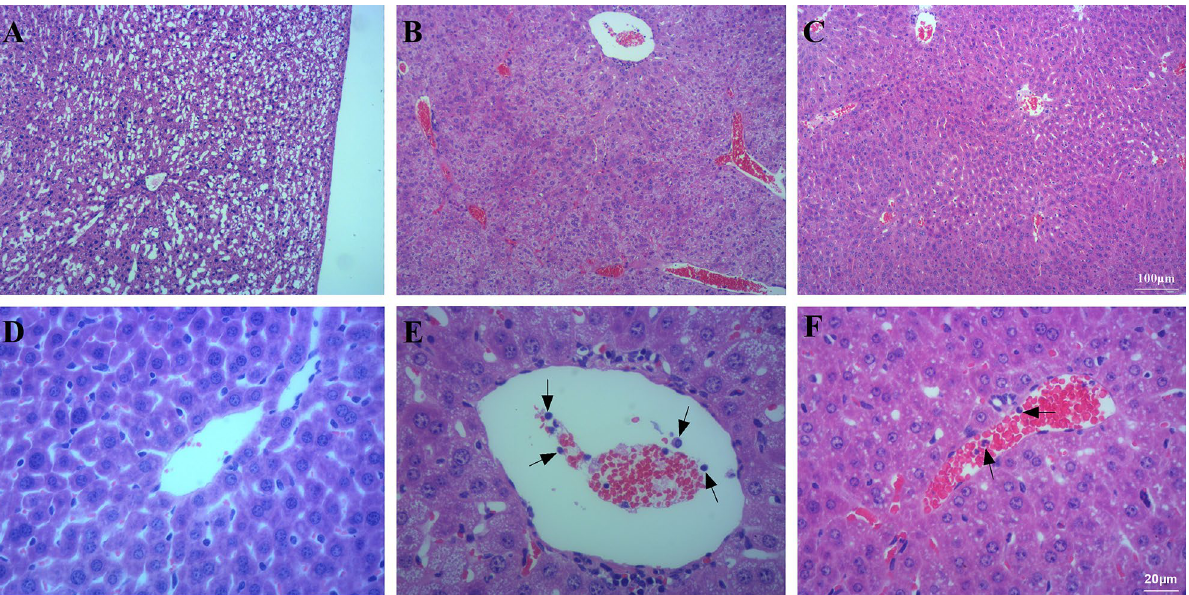
Figure 10. BM-MSCs improved LPS-induced liver injury at 48 h after LPS treatment. ( A , D ) Sham group. ( B , E ) LPS group. ( C , F ) LPS + MSC group. ( A – C , ×100 magnification. D – F , ×400